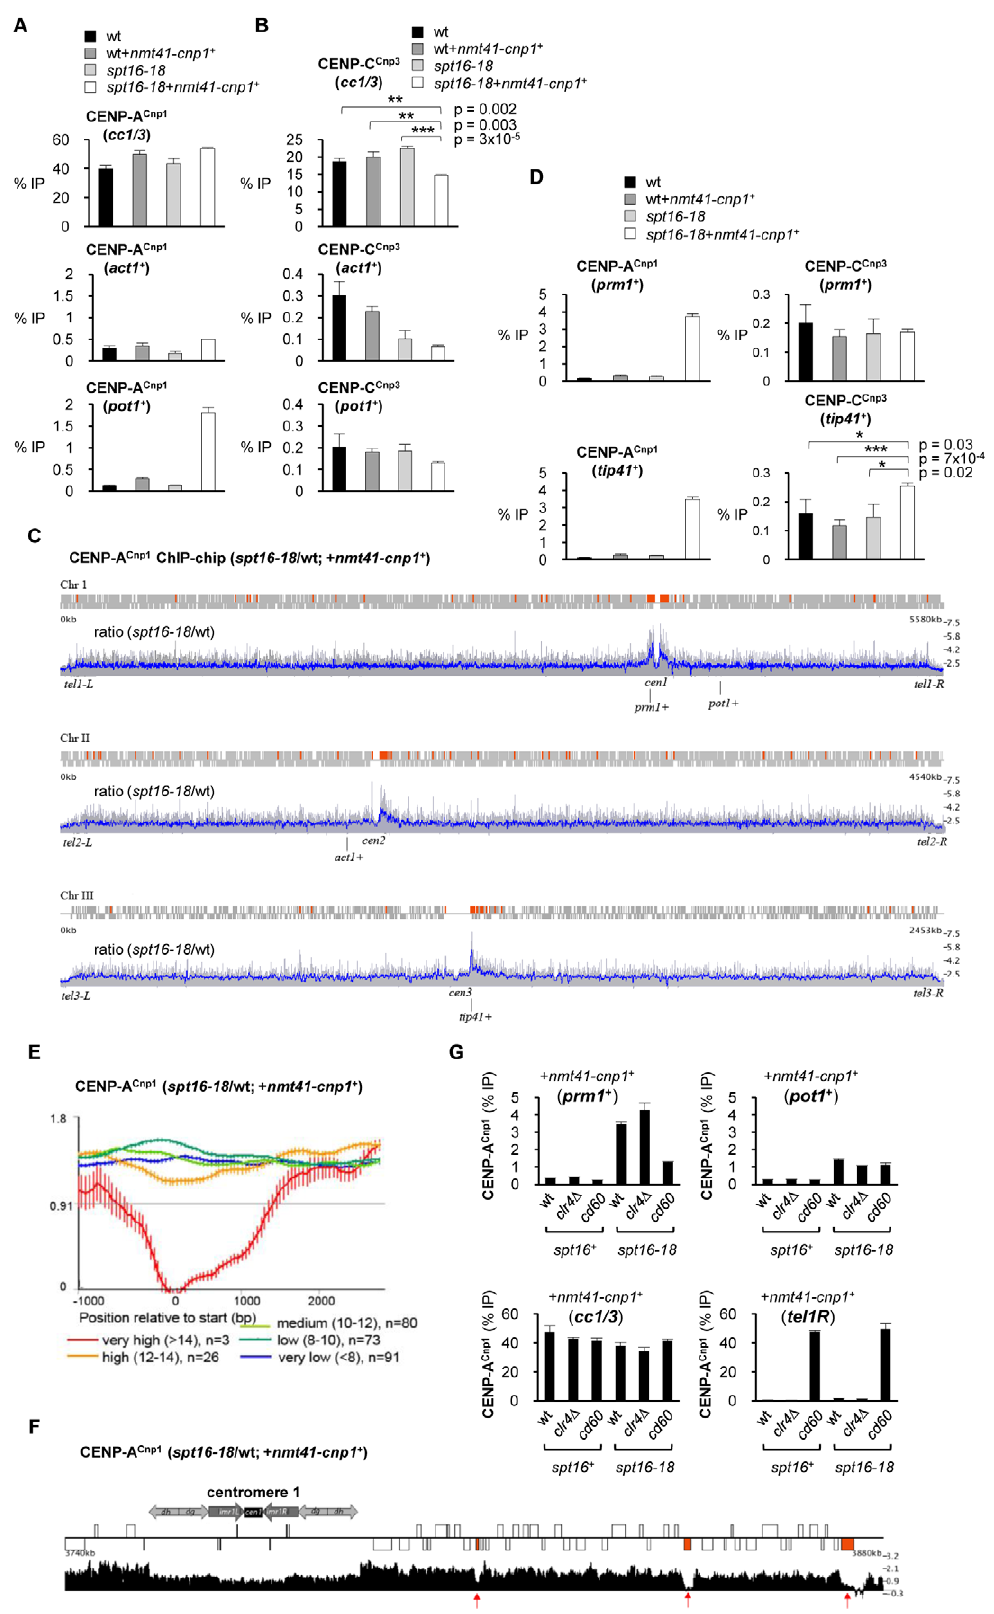
Figure 3. Spt16 prevents promiscuous incorporation of CENP-A Cnp1 . (A) ChIP analysis of CENP-A Cnp1 levels at endogenous centromeres ( cc1/ 3 ), act1 + and pot1 + in wt and spt16-18 cells in the absence or presence of OE-CENP-A Cnp1 ( nmt41-cnp1 + ; pREP41- cnp1 + integrated at ars1 locus). Cells